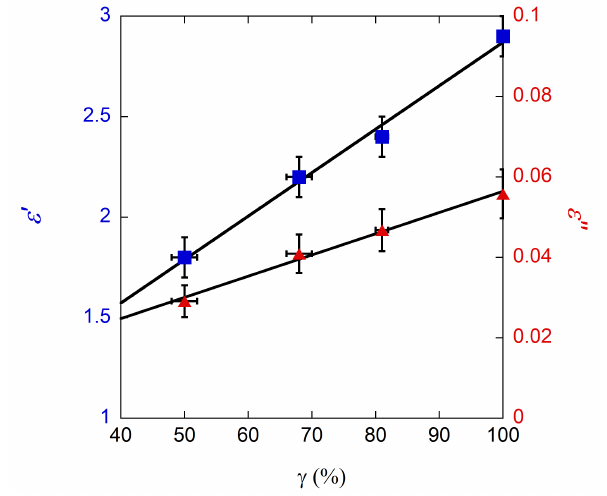
Figure 8. Real part of the relative complex permittivity (blue circles, left axis) and imaginary part (red triangles, right axis) measured on samples prepared with different porosity. The horizontal axis shows the filling percentage γ of the samples.